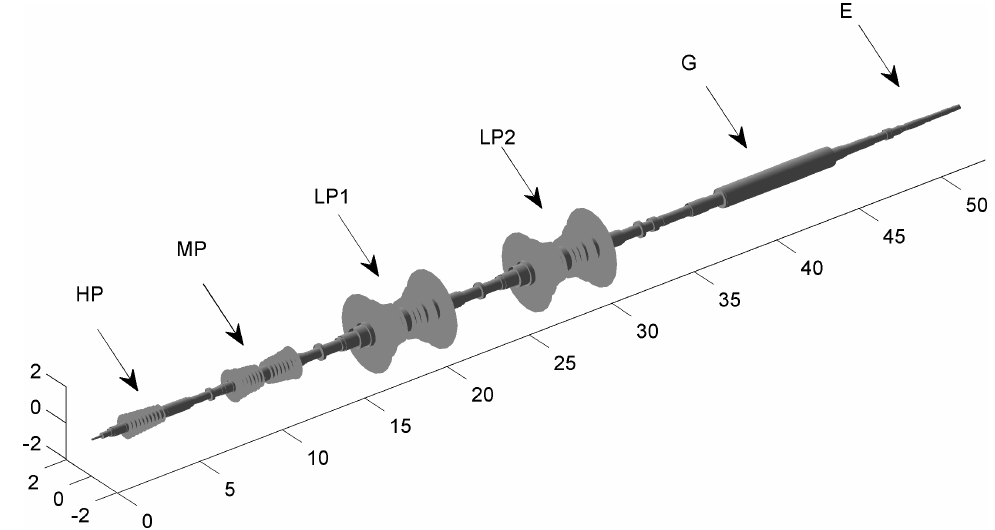
Figure 4. Visualization of a real rotor train (high pressure section, intermediate pressure section, two low pressure sections, generator and